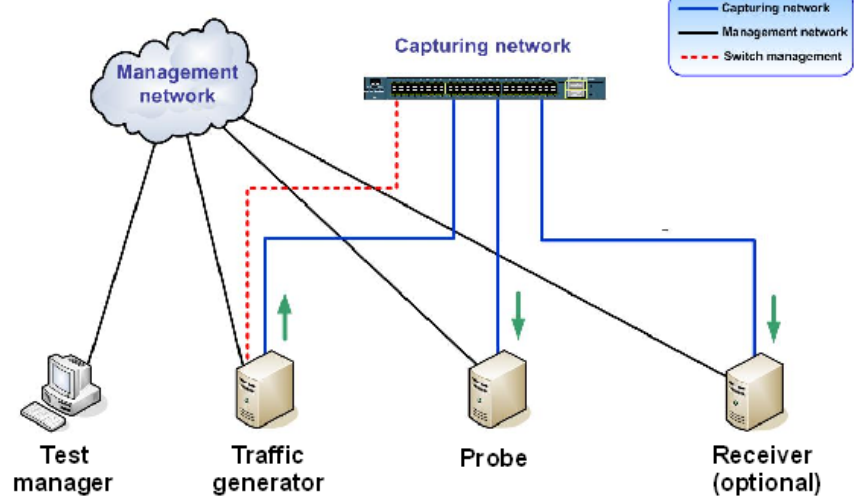
Figure 3. Testbed platform for experimental